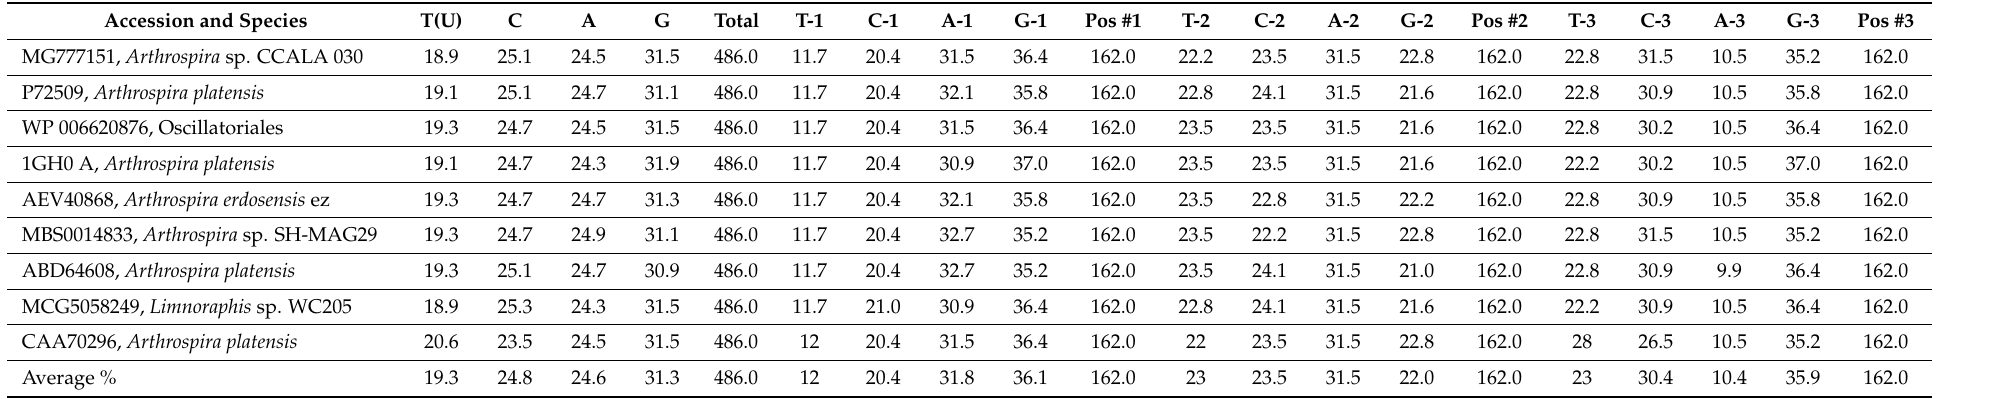
Table 3. The frequencies of the nucleotides in phycocyanin subunit alpha nucleotide sequences of nine cyanobacterial species, including A. platensis strains and variants. All nucleotide frequencies were calculated by MEGA11 and are given as